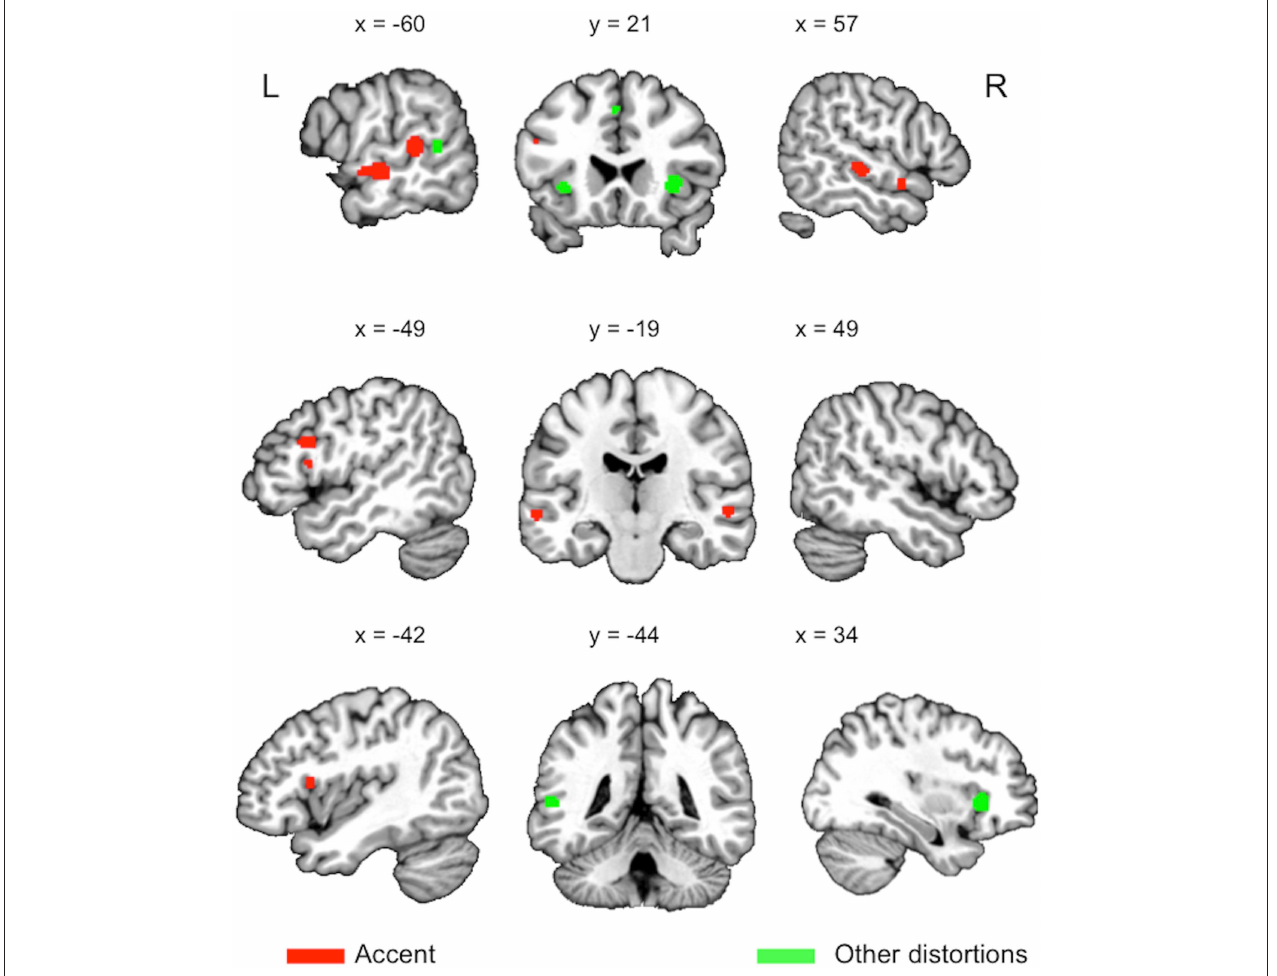
FIGURE 1 | Clusters (logical) resulting from an Activation Likelihood Estimation (ALE) analysis conducted using GingerALE 2.3.3 (www.brainmap.org), q < 0.0001 , cluster extent of 100mm 3 , for the four accent studies (red), and the seven other distortions studies (pooled noise, time-compressed, and noise-vocoded studies)